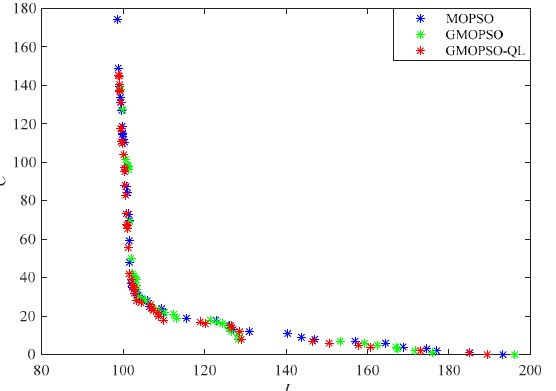
Figure 11. Pareto frontiers of MOPSO, GMOPSO, and GMOPSO-QL for UAV path planning in Case 2.